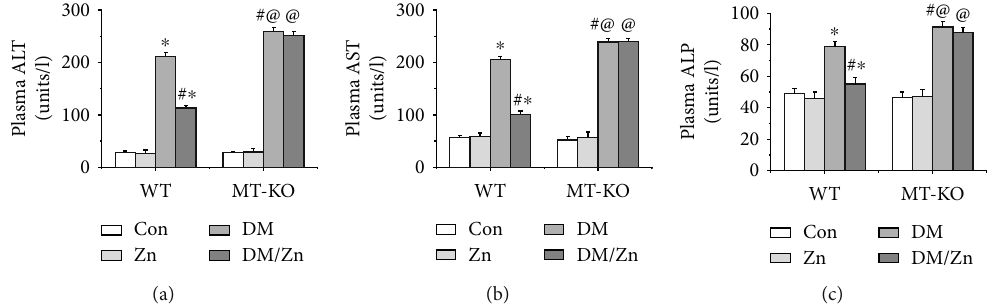
Figure 3: The e ff ect of zinc supplementation on the hepatic function in both WT and MT-KO mice under type 2 diabetes. Hepatic function is regarded as the direct maker to re fl ect hepatic damage. The damaging markers of the hepatic function, including the levels of ALT (a), AST (b), and ALP (c), were measured by the in fi nity ELISA kit. Data are presented as the mean ± standard deviation ( n = 8 /group). ∗ P < 0 : 05 vs. the control (Con) group in WT mice; # P < 0 : 05 vs. the type 2 diabetes (DM) group in WT mice; @ P < 0 : 05 vs. the control (Con) group in MT- KO